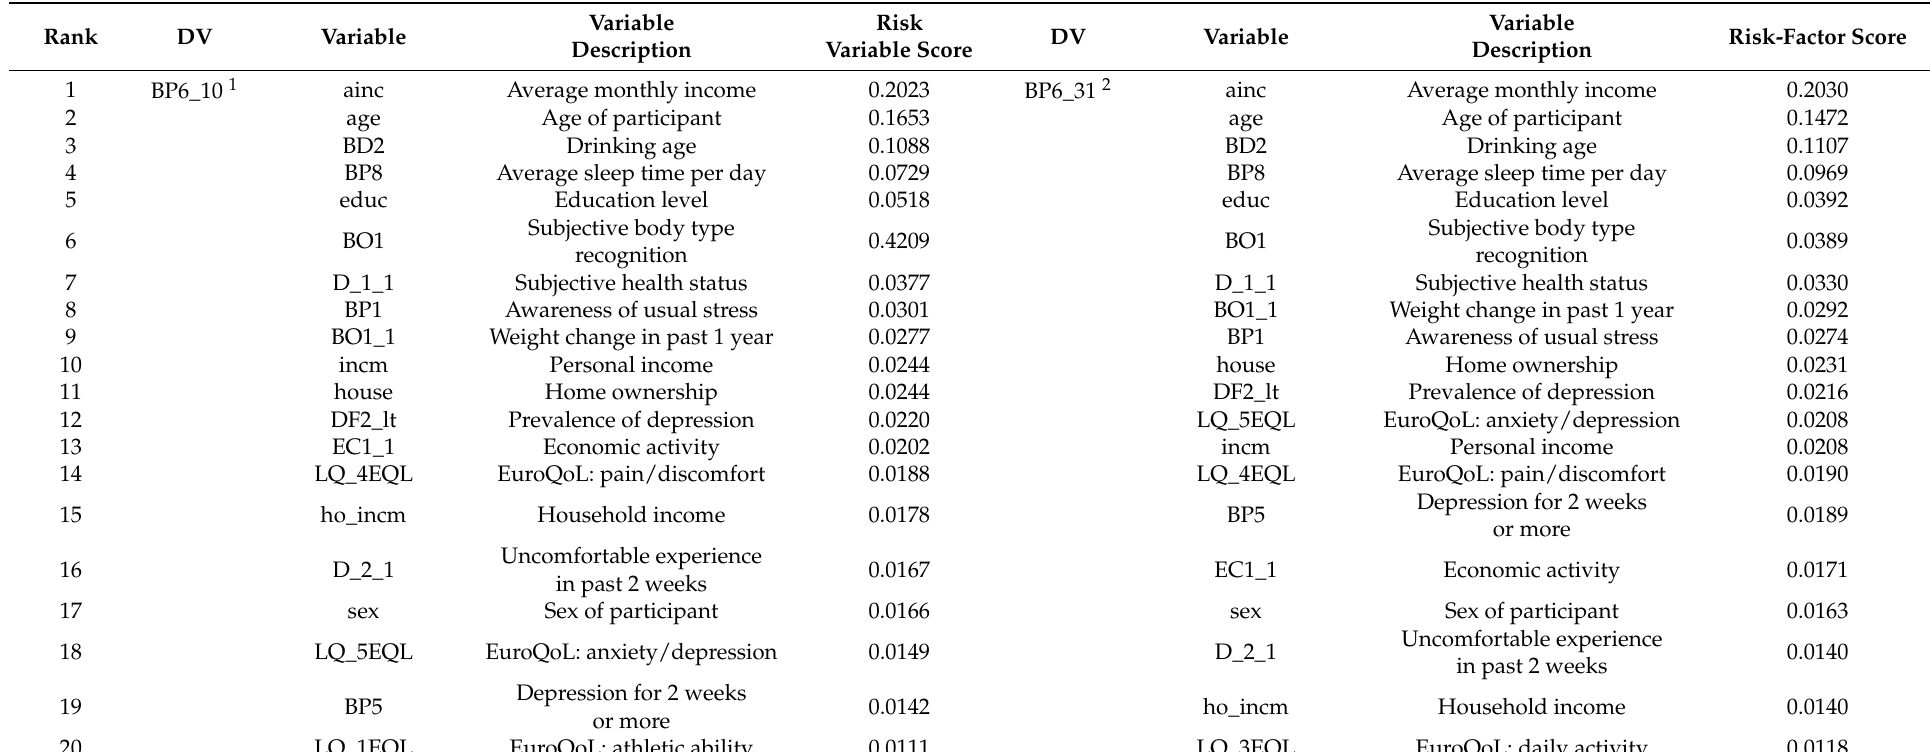
Table 8. Important features and risk-factor score in the integrated